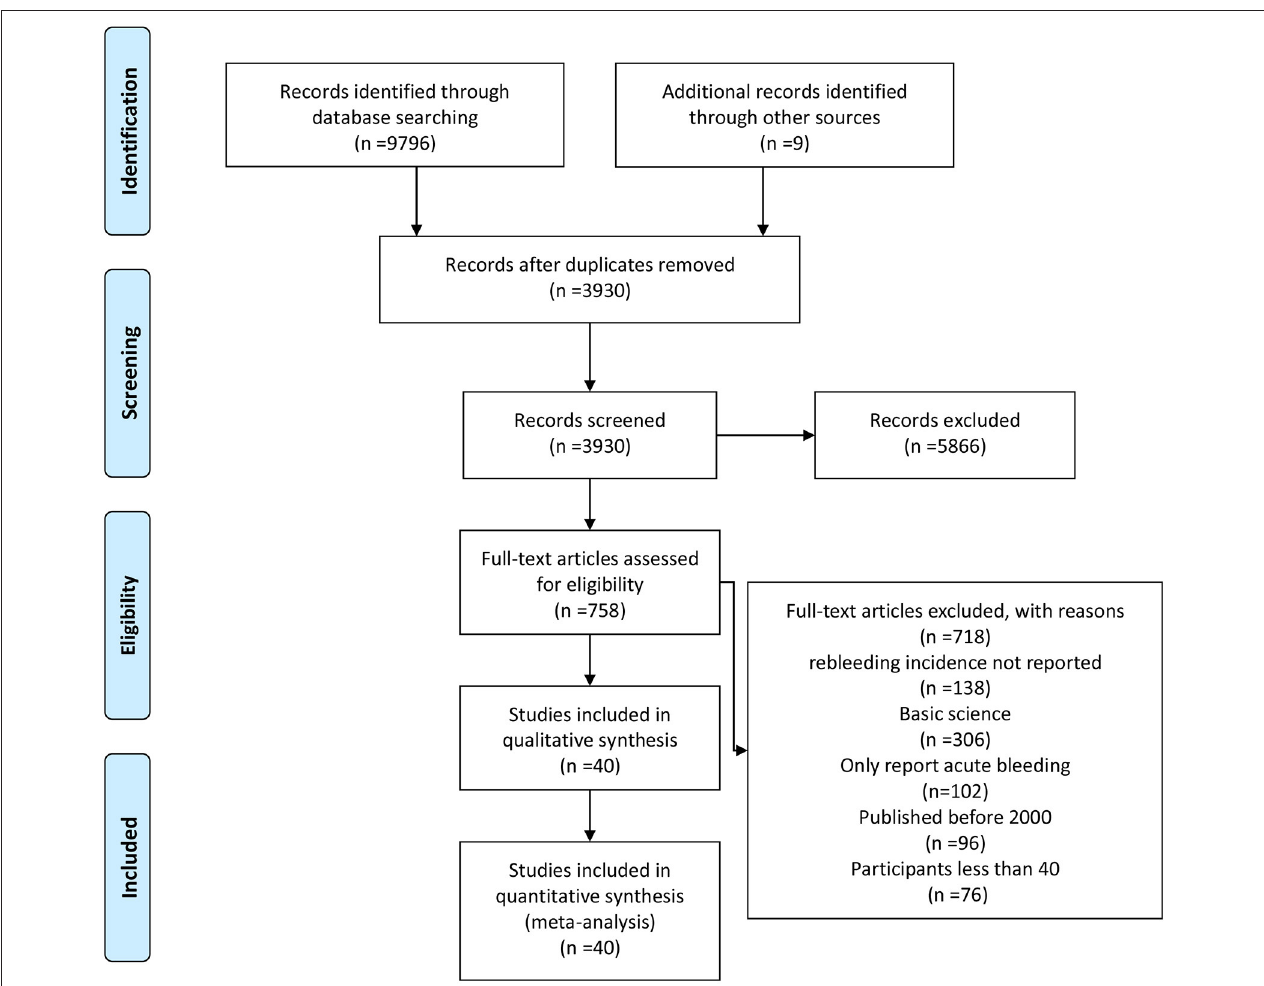
FIGURE 1 | Flow chart of the study